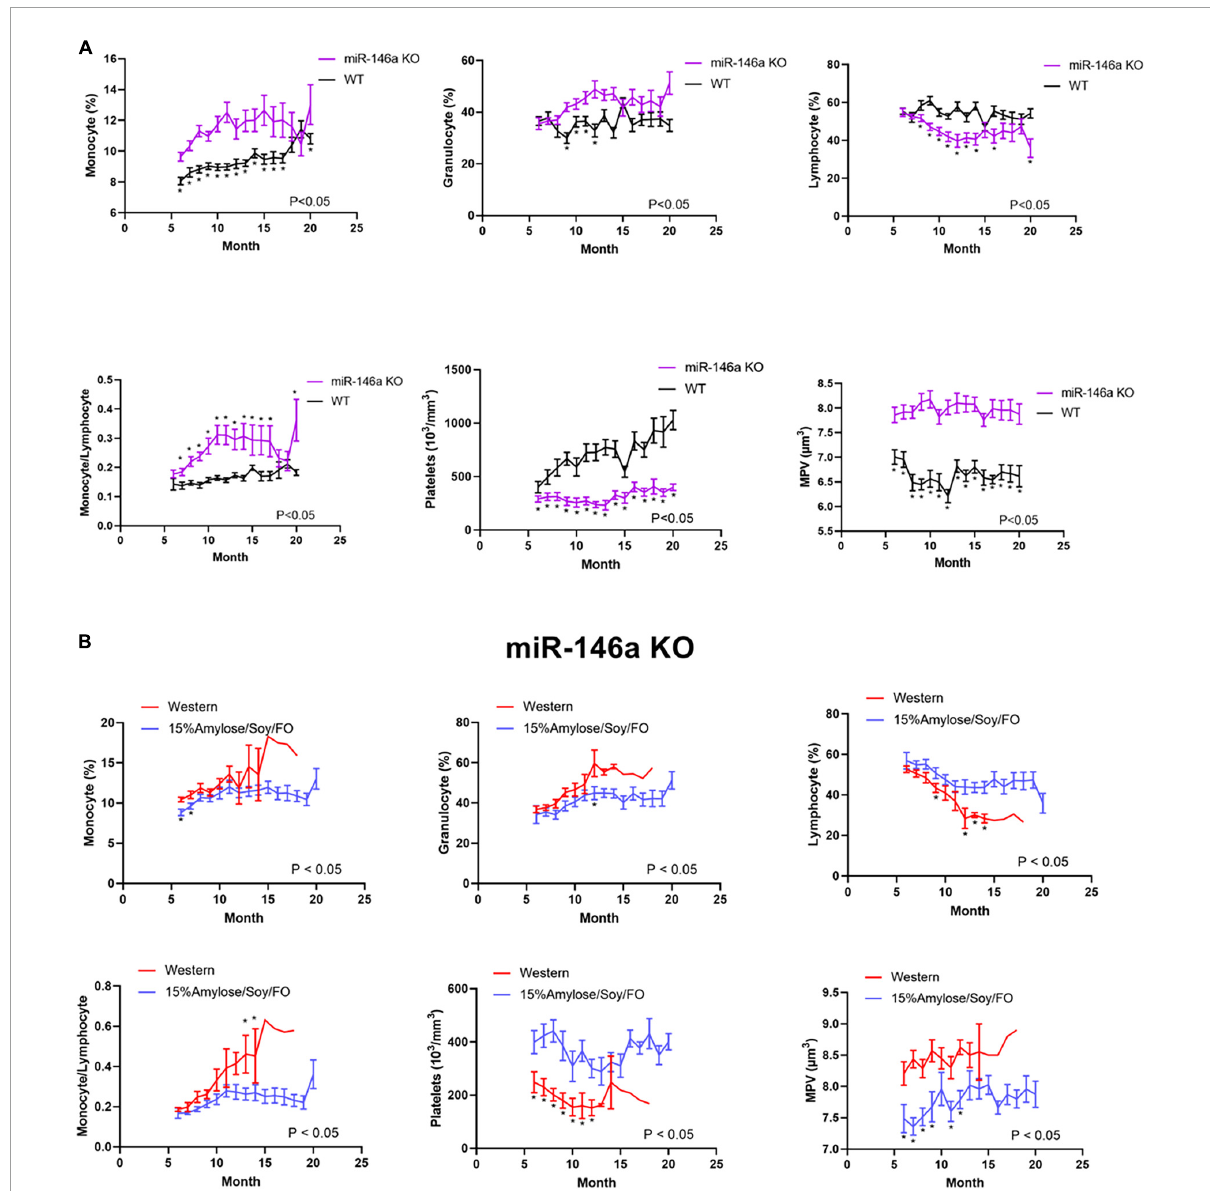
FIGURE2 A 15%Amylose/Soy/FO diet ameliorates the blood cell profile changes associated with miR-146a KO mice. (A) A comparison of the lymphocytes, monocytes, granulocytes, and platelets over time in WT and miR-146a KO mice on a Western diet. The data are shown as the means ± SEM of 10 WT and 15 miR-146a KO mice. (B) A comparison of the lymphocytes, monocytes, granulocytes and platelets over time in miR-146a KO mice on a Western ( n = 15) vs. a 15%Amylose/Soy/FO ( n = 15) diet. The data are shown as the means ± SEM. *Indicates significant differences ( P <